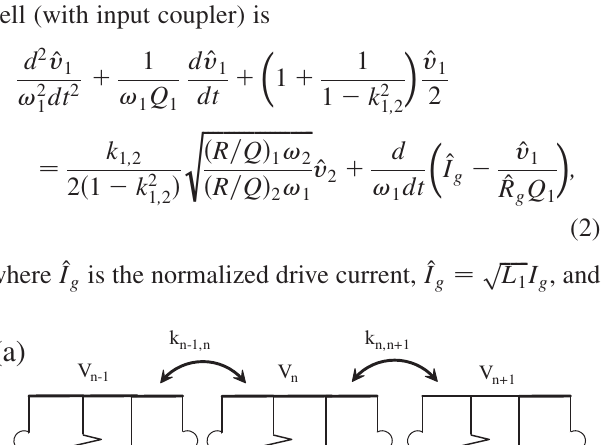
ffiffiffiffiffiffiffiffiffiffiffiffiffiffiffiffiffiffiffiffiffiffiffiffiffiffiffi ð R=Q Þ